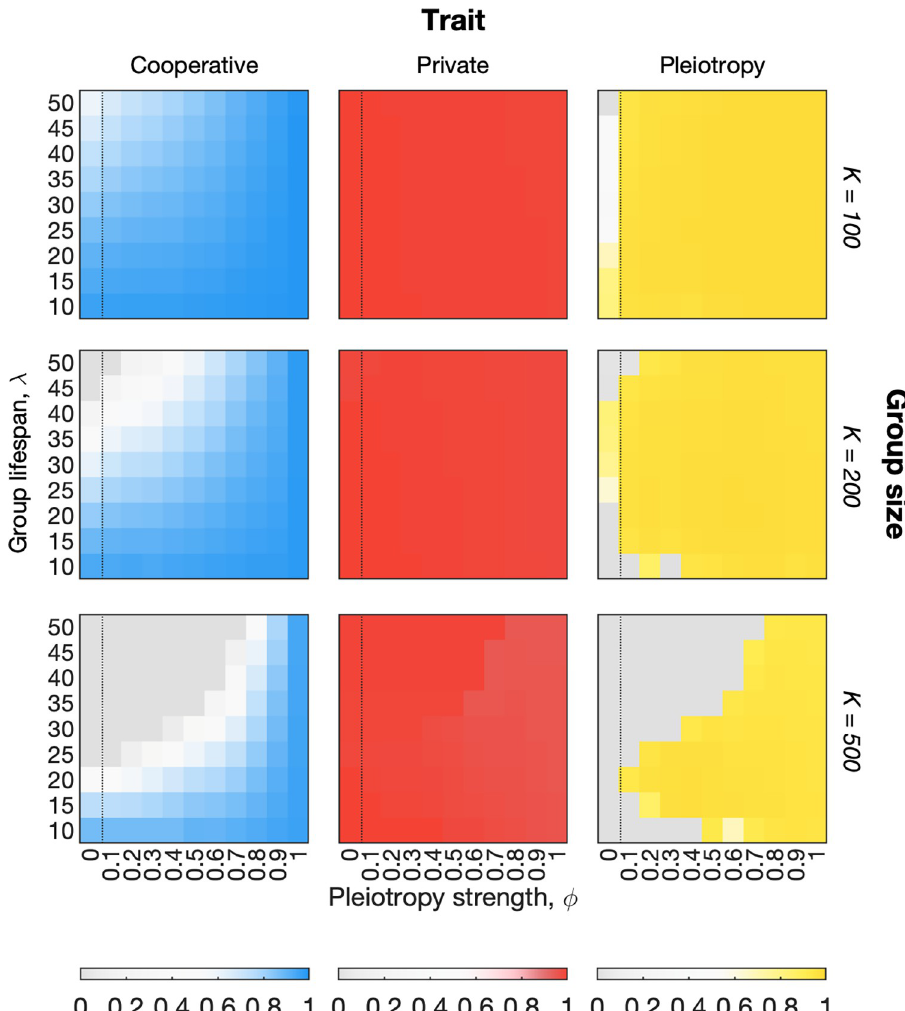
Fig 4. The evolution of pleiotropy promotes cooperation. Heatmaps show average trait values among the global population of cells (across all groups) at steady state in our model. Results are shown for 3 group sizes (increasing from top to bottom). Dotted line on each heatmap indicates separation between point where pleiotropy has no effect (control case ϕ = 0) to regions where it has a nonzero influence on the dynamics. Cooperation evolves for a wide range of parameters but is destabilised for longer group life spans, λ , and larger group sizes, K , due to the emergence of cancerous cell lineages. This effect is strongest without pleiotropy ( ϕ = 0). When pleiotropy has an effect ( ϕ > 0), natural selection favours its evolution resulting in higher levels of cooperation, i.e., the blue intensity increases from left to right in the cooperation plot. As expected, pleiotropy is most favoured when it is more effective, i.e., the strength of pleiotropy, ϕ , is higher. Note that the level of expression of the pleiotropic trait can be nonzero even when it has no effect due to stochastic effects. In these situations, however, the expression of the pleiotropic trait does not influence cooperative evolution. We show below that pleiotropy will also evolve with a cost, which greatly reduces this stochasticity (S11 Fig). Parameters: s c = s g = 0.95; K = 200; μ = 0.0001; ν = 0.01. The code required to generate this figure can be found at https://github.com/euler-mab/pleiotropy and https://zenodo.org/record/6367788#.